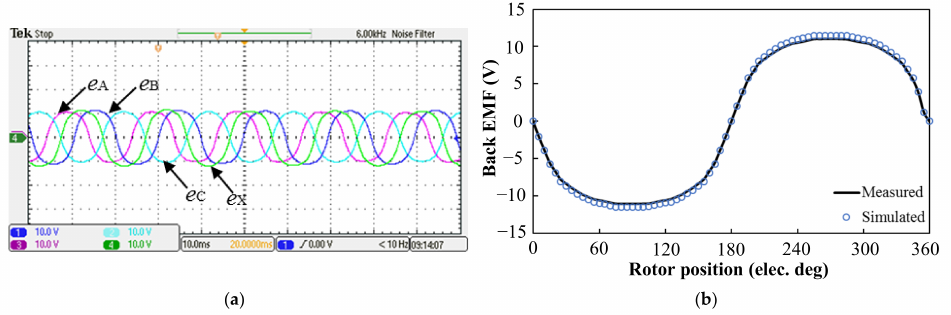
Figure 17. Back-EMF waveform with no-load at the speed is 1000 r/min. ( a ) Measured results, ( b ) simulated